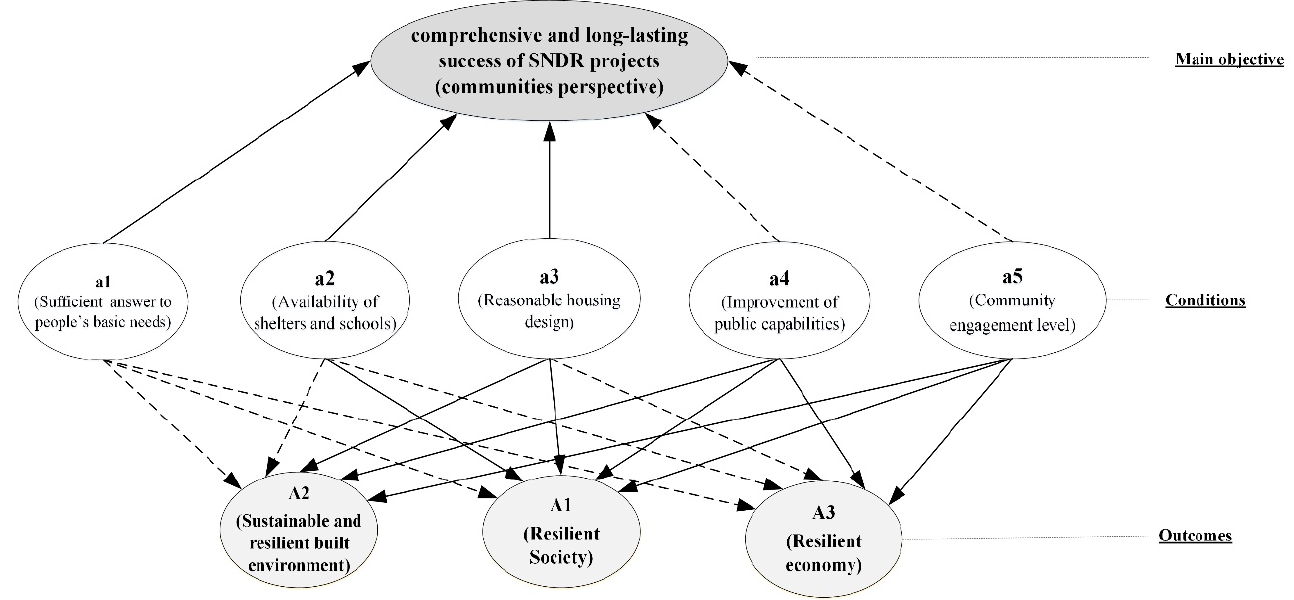
Figure 3. Success evaluation model for SNDR projects per community perspective. Dashed lines indicate the presence and absence of conditions that may affect the connected outcome, while solid lines represent the presence of conditions that affect the subsequent outcome.